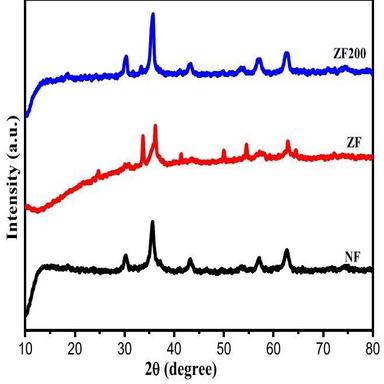
X-ray diffraction of nickel ferrite (NF), zinc ferrite (ZF) and ZF heated at 200 °C(ZF200).